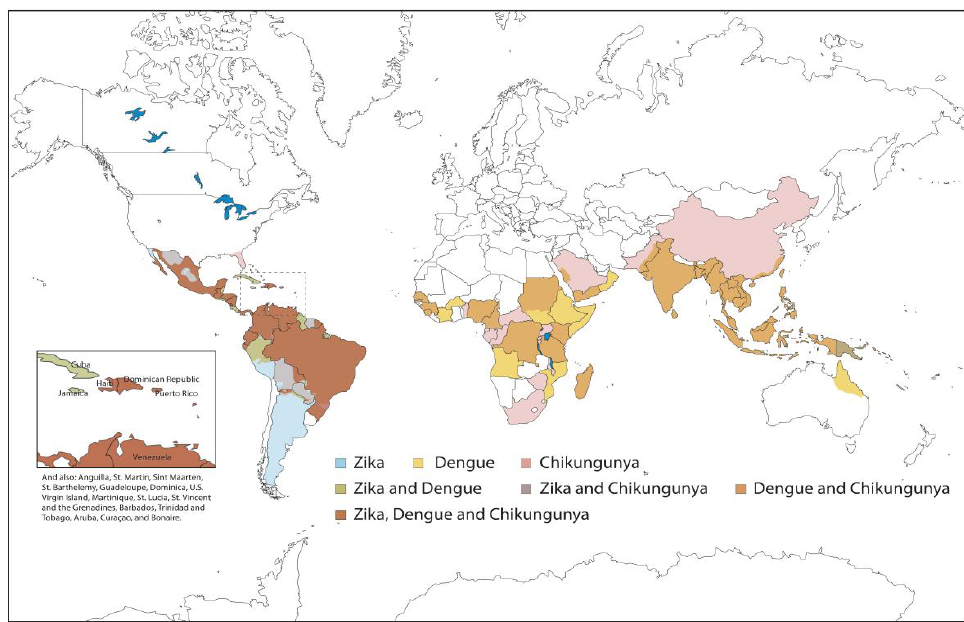
Figure 1. Map showing the estimated global distribution of dengue, Zika, and